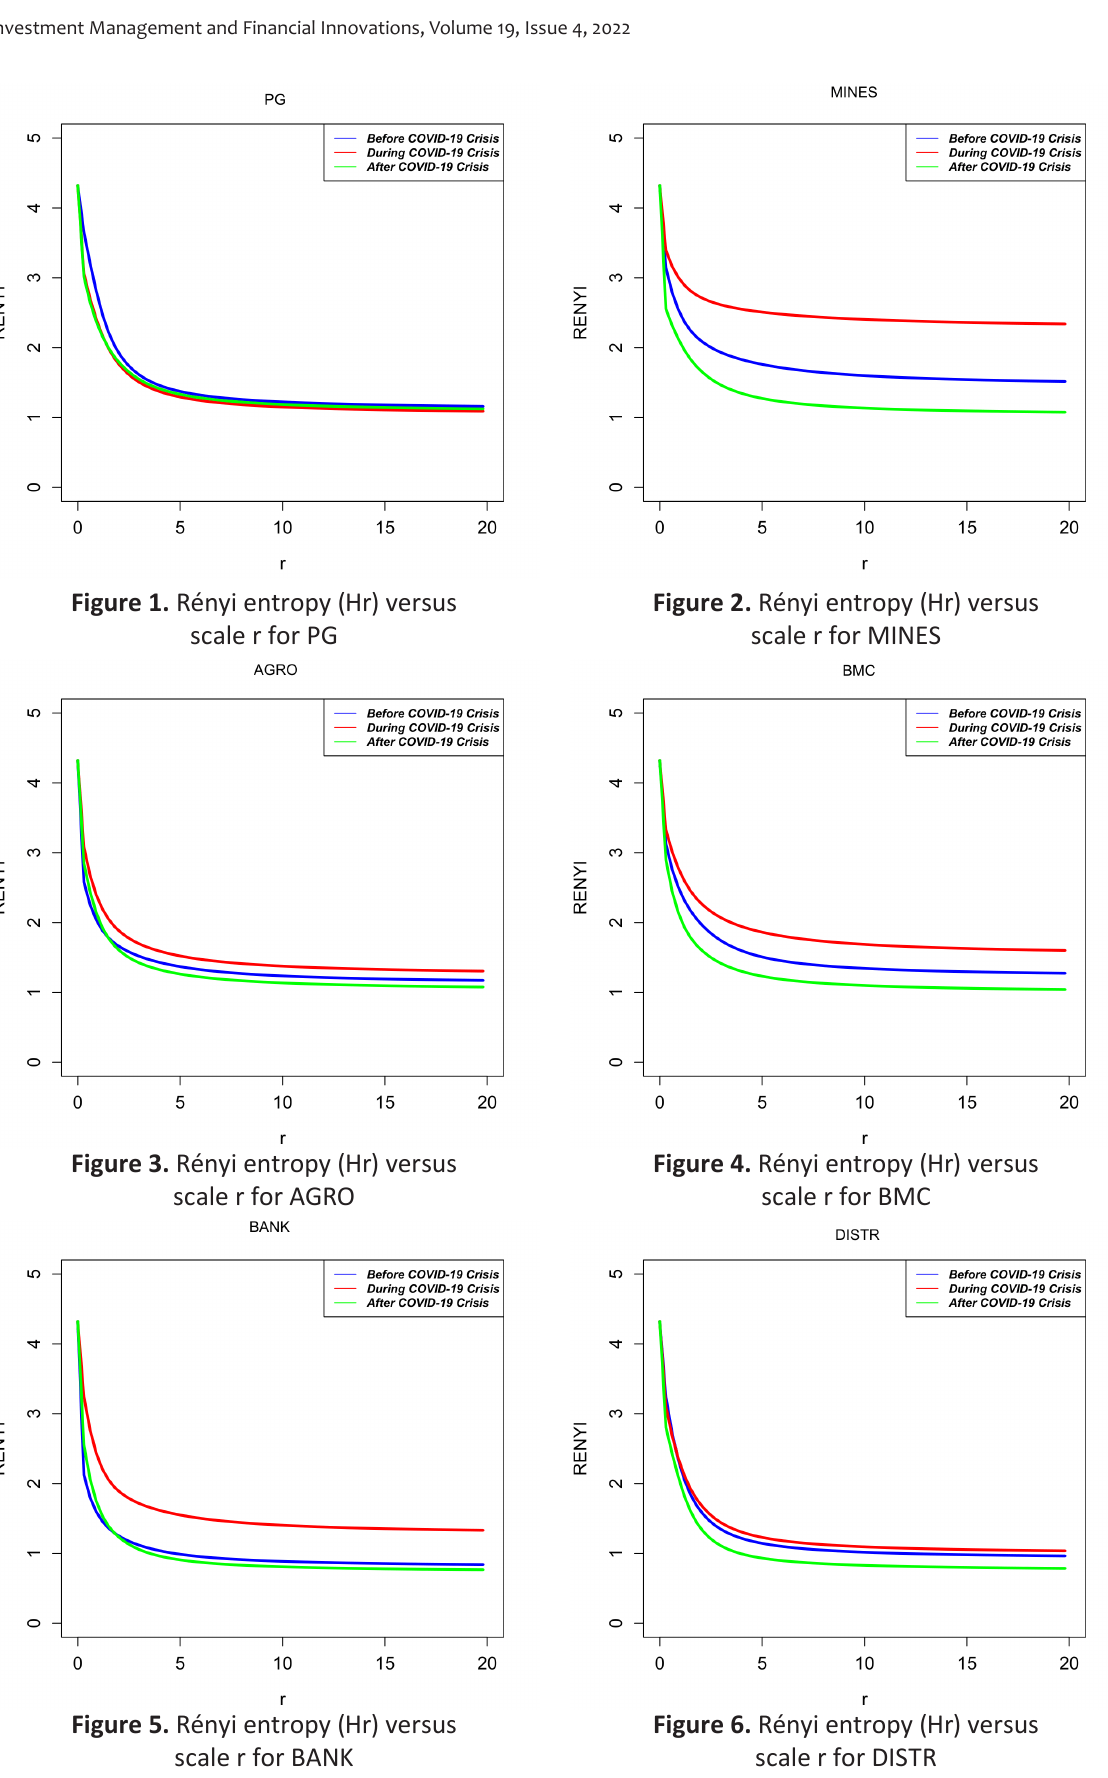
Figure 6. Rényi entropy (Hr) versus scale r for